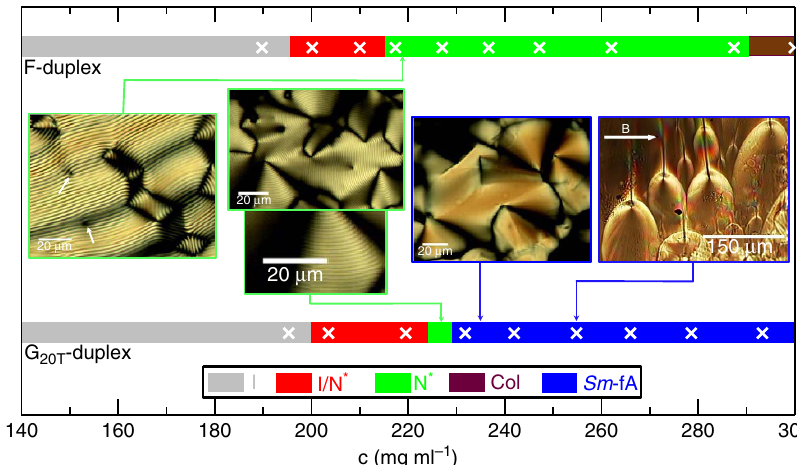
Figure 3 | Phase diagram of gapped versus full-paired DNA duplexes. Phase diagrams at room temperature for the G 20T -duplex in the bottom panel, and for the full-paired F-duplex in the top panel, as a function of the total DNA concentration. The colour code for the different phases is given in the lower right insert. The white crosses indicate the concentrations of samples that were loaded into capillaries for SAXS measurements. Phase identification was carried out by the combination of SAXS experiments, visual inspection of the capillaries between cross-polarizers and selective recording of the optical textures as observed by POM. POM images of DNA samples, confined in flat capillaries with thicknesses varying between 20 and 50 m m, are presented as inserts with coloured arrows that indicate their location in the phase diagram. The second from the left two POM images are for the same concentration of the G 20T -duplex, where the lower image is a magnification of the lower left part of the upper image, showing the chiral nature of the N *-phase. The white arrows in the most left POM image indicate the presence of isolated dislocations within the cholesteric stripe texture. The most right POM image of a magnetic-aligned 255mgml (cid:2) 1 solution of G 20T -duplexes, taken from a thin sample area located at the walls of a round X-ray capillary.